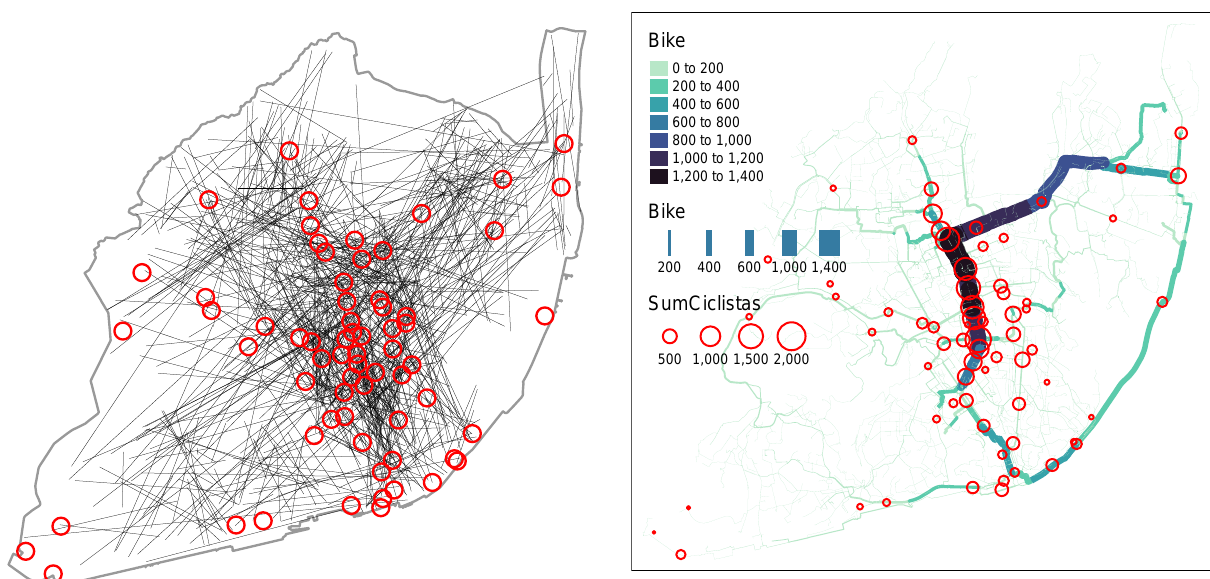
Figure 6. Route network from jittered desire lines with disagregation of 500 trips, with routes from CycleStreets, in quietest routing option.